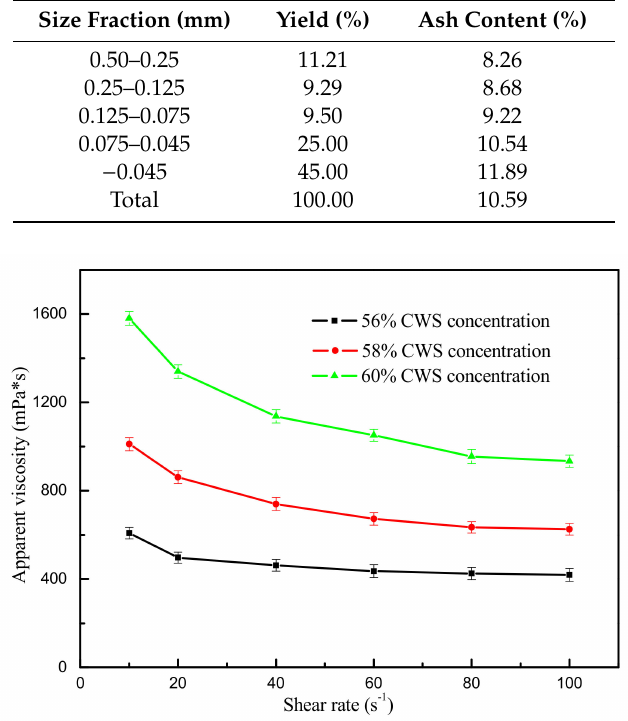
Figure 8. E ff ect of shear rate on apparent viscosity of CWS in the presence of di ff erent concentrations (the data points represent the mean values (n = 3) ± standard